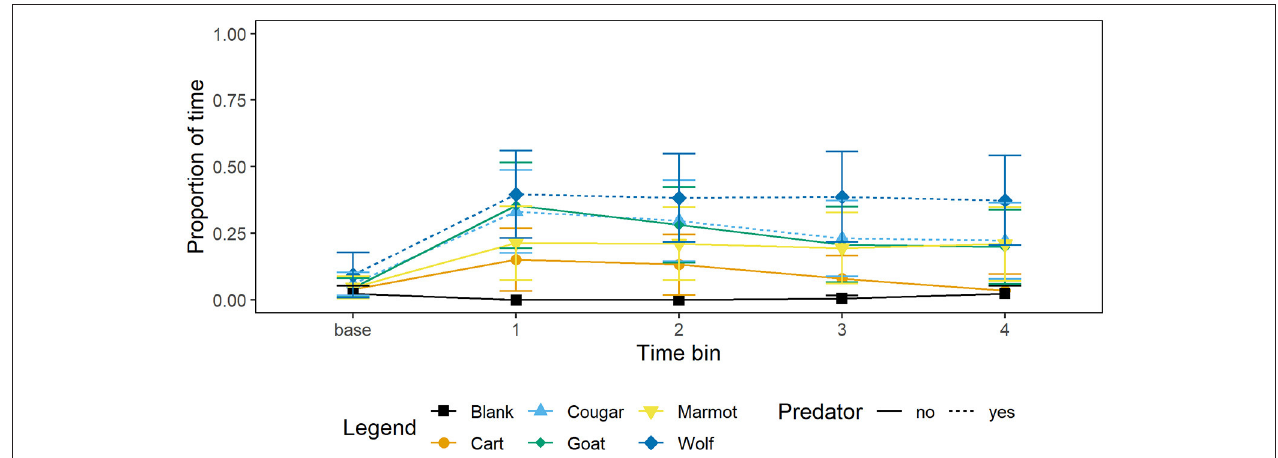
FIGURE 2 | Mean proportion of time and 95% CI per 15s time bin that marmots ( n = 34) spent vigilant at the burrow or in the burrow when presented with each of four mammal taxidermy mounts, a cart, and when a blank was scored. Baseline value represents proportion of 60s prior to the stimulus being presented that marmots allocated to vigilance at the burrow or time in the burrow.